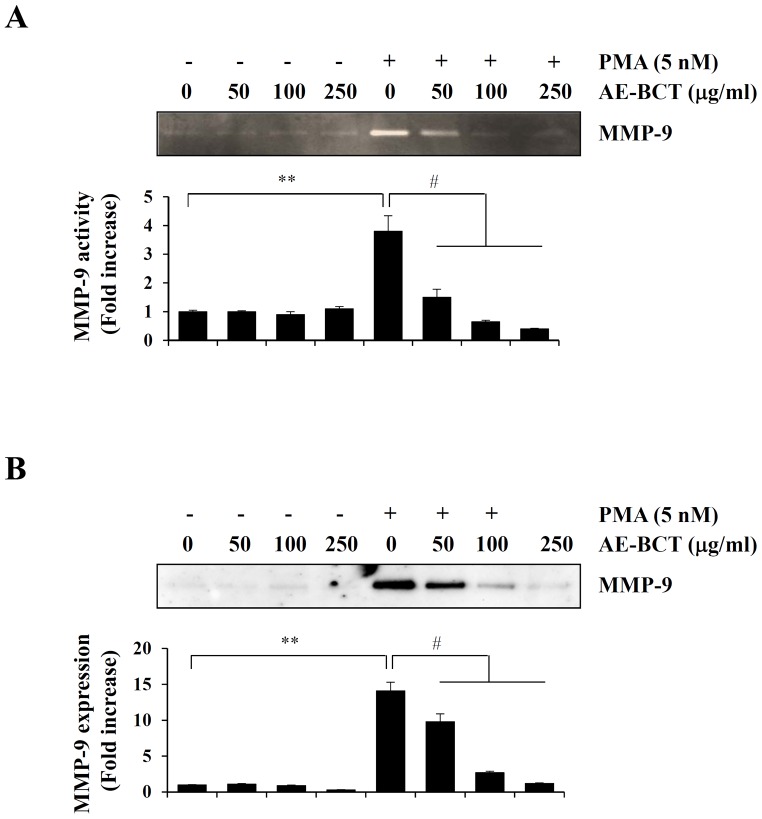
Effects of AE-BCT on MMP-9 activity and expression in HT1080 cells.Cells pre-treated with AE-BCT for 12 h were incubated in serum-free medium with or without 5 nM PMA for a further 24 h. Conditioned media were collected and analyzed for the activity and expression of MMP-9 by gelatin zymography (A) and Western blotting (B), respectively. Bar graphs shows fold increases in band intensity compared with untreated control cells. Data are expressed as means ± SD of three independent experiments. **p<0.01 vs untreated control, #
p<0.01 vs PMA stimulation.